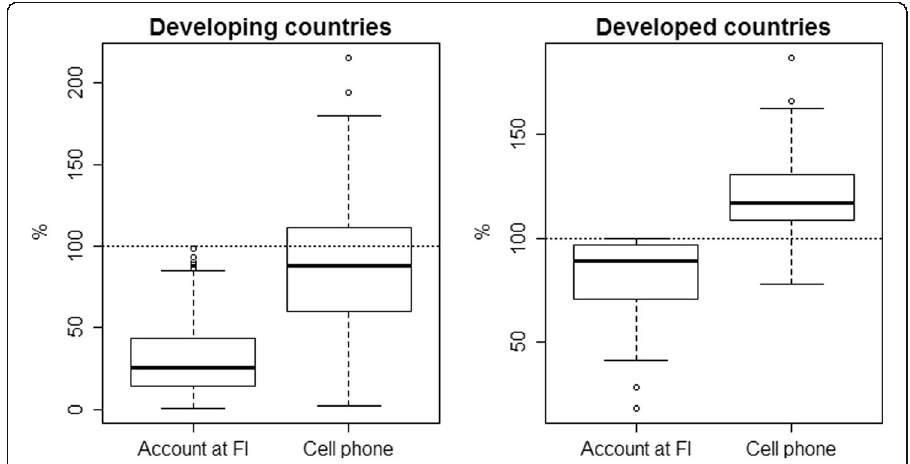
Fig. 1 Financial services and the reach of telecom services. Demirguc-Kunt et al. (2015), International Telecommunication Union (2015). Account at FI is the share of individuals above 15 years old who have an account at a financial institution in a country, while Cell phone is the number of mobile cellular subscriptions per 100 people. Developing and developed countries are set according to the United Nation ’ s statistics